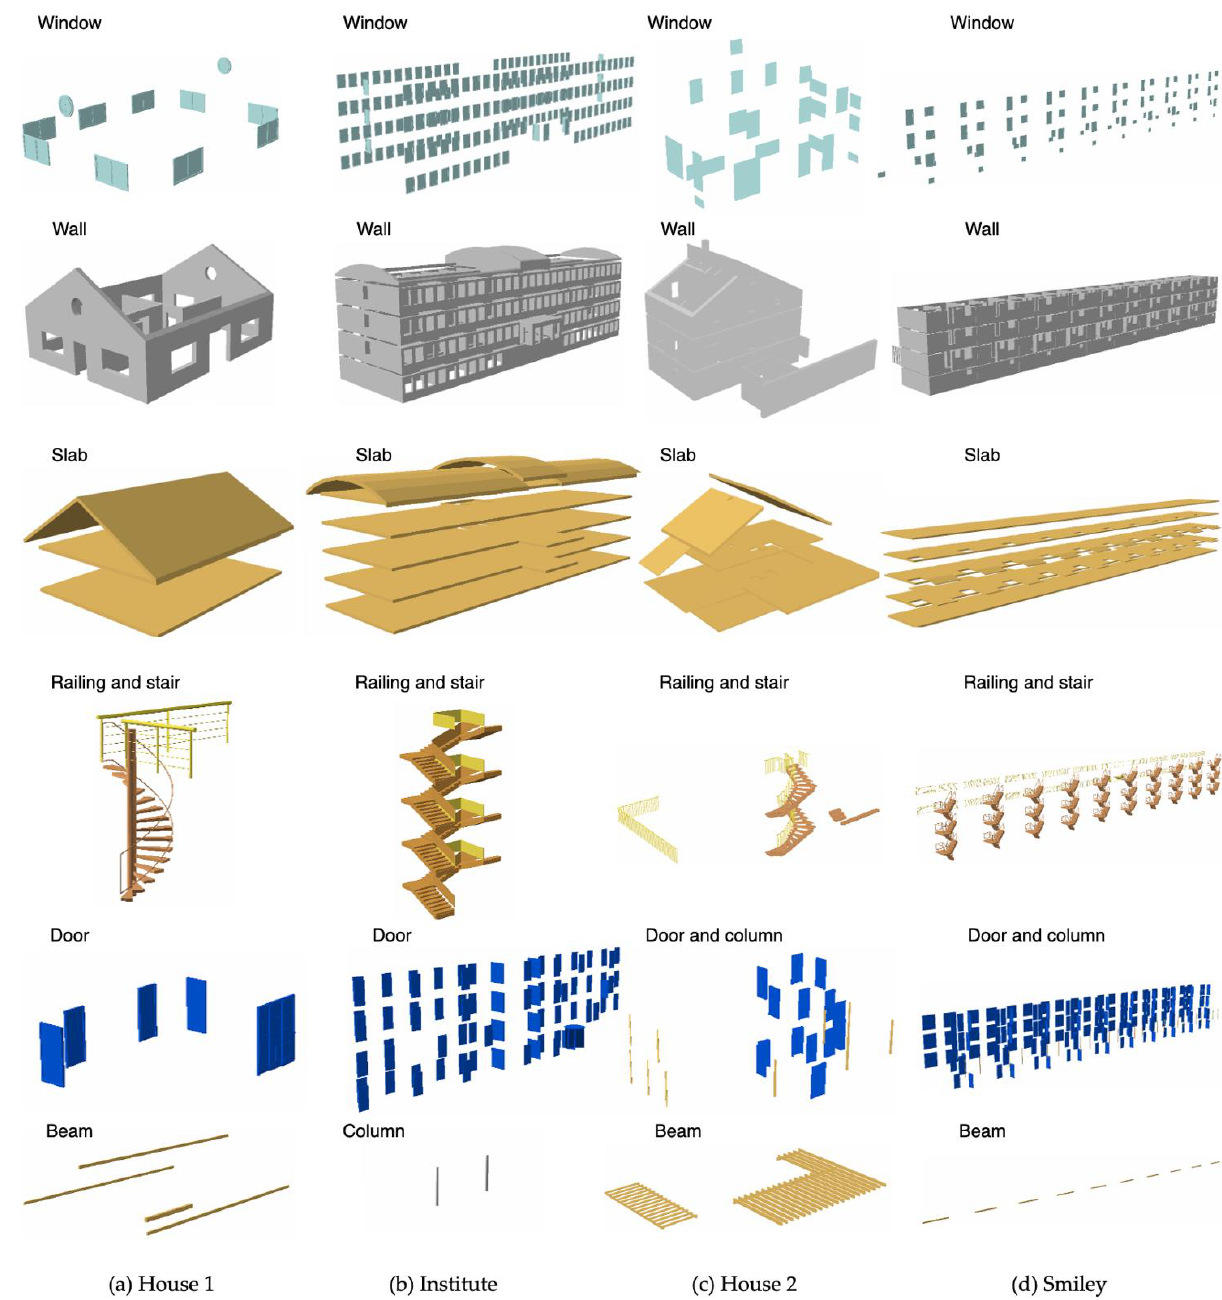
Figure 15. Converted building components in shapefile for ( a ) House 1, ( b ) Institute, ( c ) House 2, and ( d ) Smiley. The original building components in IFC are presented in Figure 16, which were visualized using FZKViewer. The comparison between the converted building components and the original building components shows that all building components have been generated. Some doors and windows of these models in Figure 16 are open, which is a feature of the FZKViewer that can show the status of doors and windows. When visualized using Autodesk Revit, these doors and windows are closed.